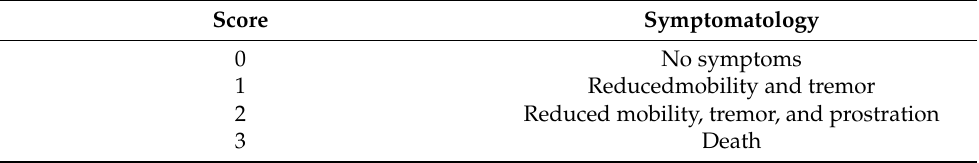
Table 1. Criteria for classifying endotoxemia according to the severity of the symptoms.